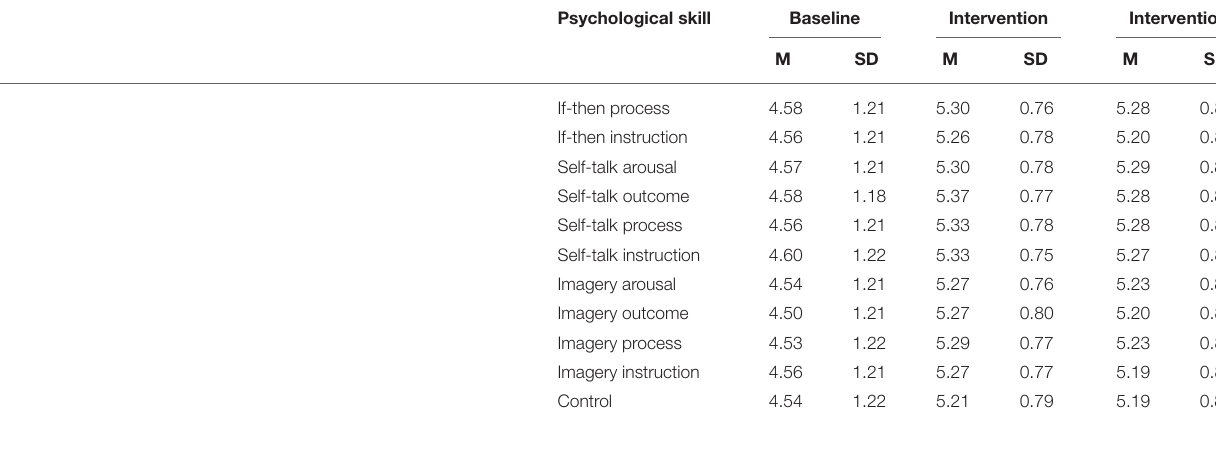
TABLE 6 | Univariate results for time, accuracy, effort, self-rated performance, emotion and arousal.